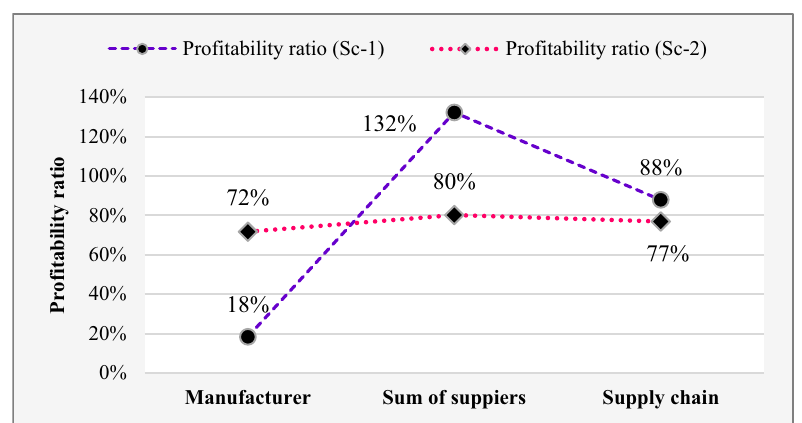
Fig. 13 A comparison of the profitability ratios for SC, suppliers, and the manufacturer in Sc-1 and Sc-2 for problem size